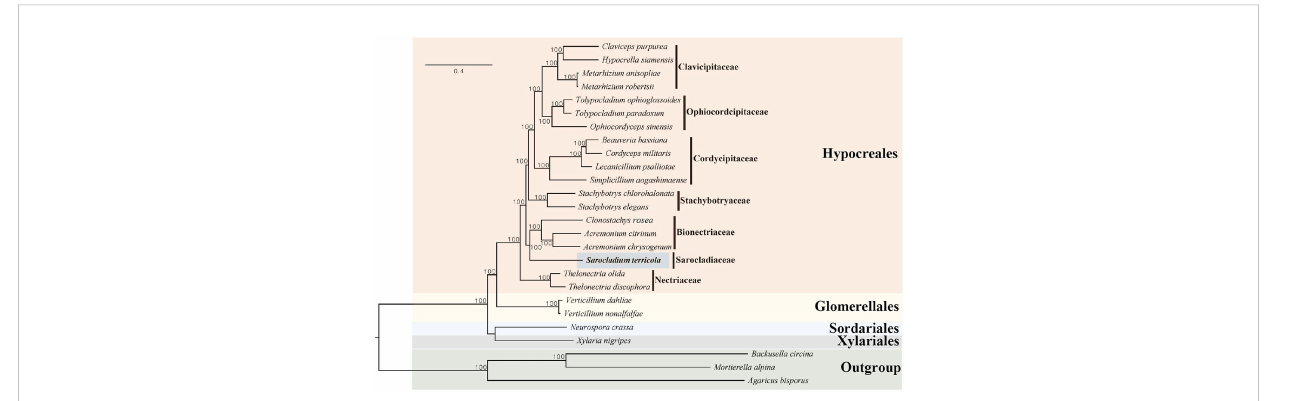
FIGURE 3 Maximum Likelihood phylogenomic tree based on the amino acids encoded by 268 single copy ortholog genes from 26 ascomycetes. The new genome sequence from the present study is highlighted in blue. Maximum Likelihood bootstrap values ( ≥ 95%) are indicated along branches. A scale bar in the upper left indicates substitutions per